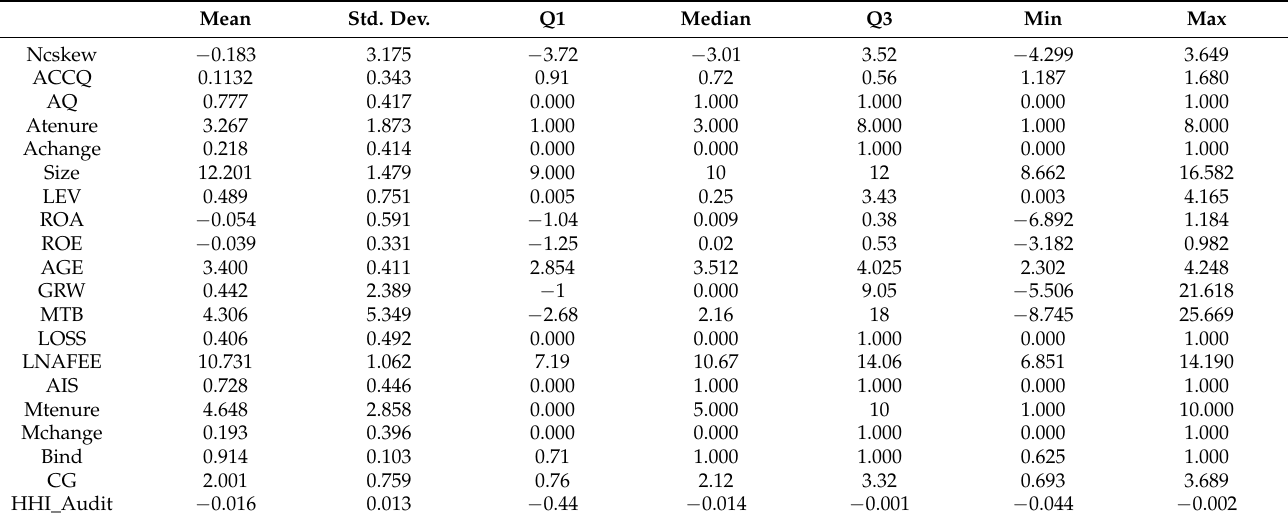
Table 2. The descriptive statistics.